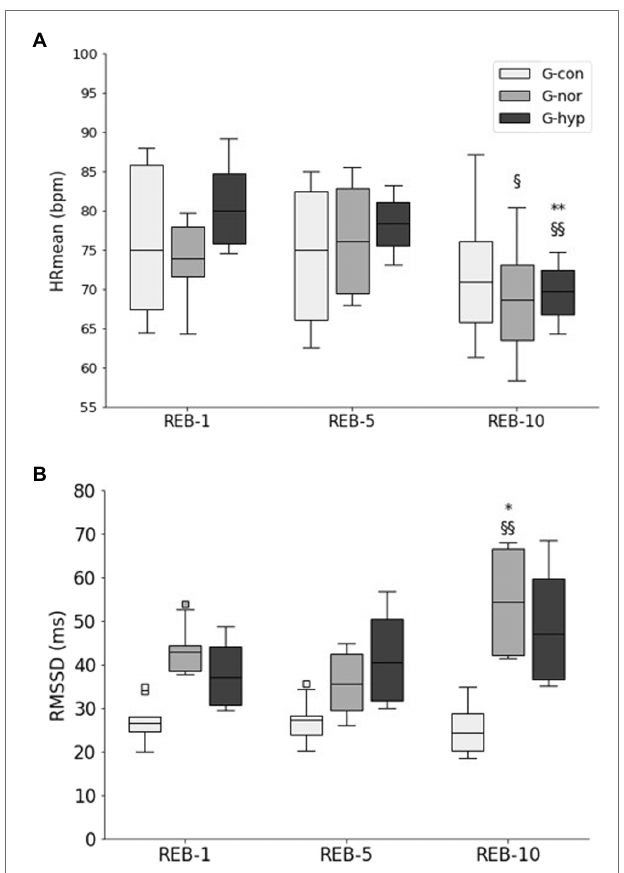
FIGURE 5 | Changes in cortisol (A) and α -amylase (B) concentrations measured before and after the Rebalance© Program. G-con, control group; G-nor, normotensive group; G-hyp, hypotensive group. Pre-REB, prior to Rebalance© Program; Post-REB, following Rebalance© Program. Box plots represent median interquartile range (IQR, Q25–Q75), and error bars are maximal and minimal observations within 1.5 × IQR. Squares represent maximum and minimum observations above or below 1.5 × IQR. ∆∆ Significantly different from G-con ( p < 0.01); ° Significantly different from G-nor ( p <